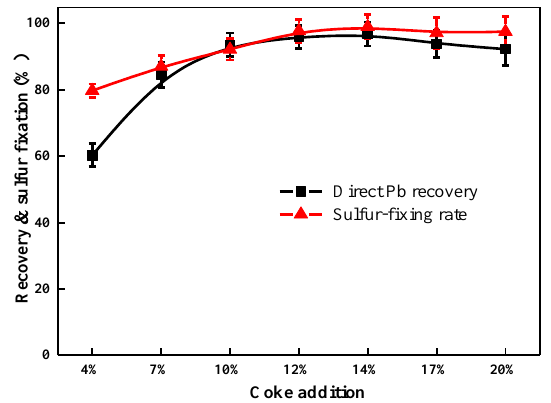
Figure 5. Theeffectsofcokedosageonleadrecoveryandsulfurfixation. (W lead paste :W Na2CO3 :W pyrite cinder Figure 5. The effects of coke dosage on lead recovery and sulfur fixation. (W lead paste :W Na2CO3 :W pyrite cinder = 200:16:50 g, FeO / SiO = 1.3, CaO / SiO = 0.4, 1200 ◦ C, 2 = 200:16:50 g, FeO/SiO 2 = 1.3, CaO/SiO 2 = 0.4, 1200 °C, 2 h). 2 2